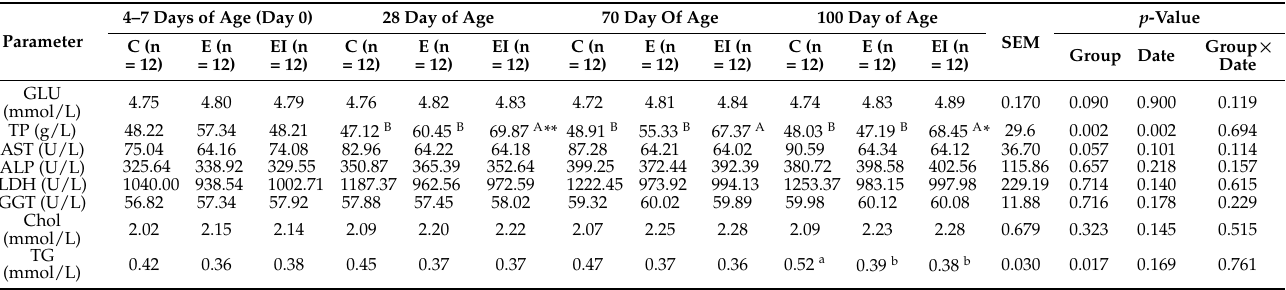
Table 4. Biochemical parameters in